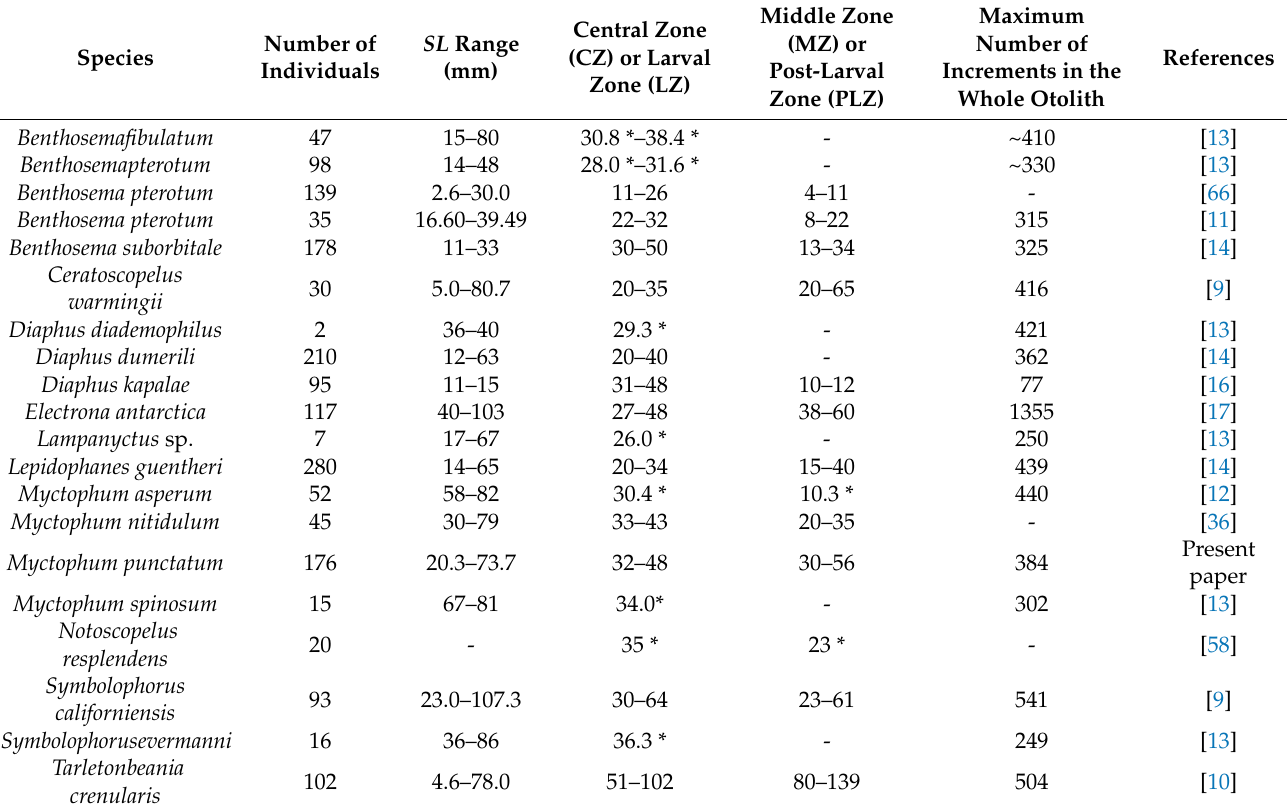
Table 5. Number of increments in the otolith zones in studies regarding age, growth and microstructure of lanternfish species. When information on the increments’ range was lacking, the mean value was provided